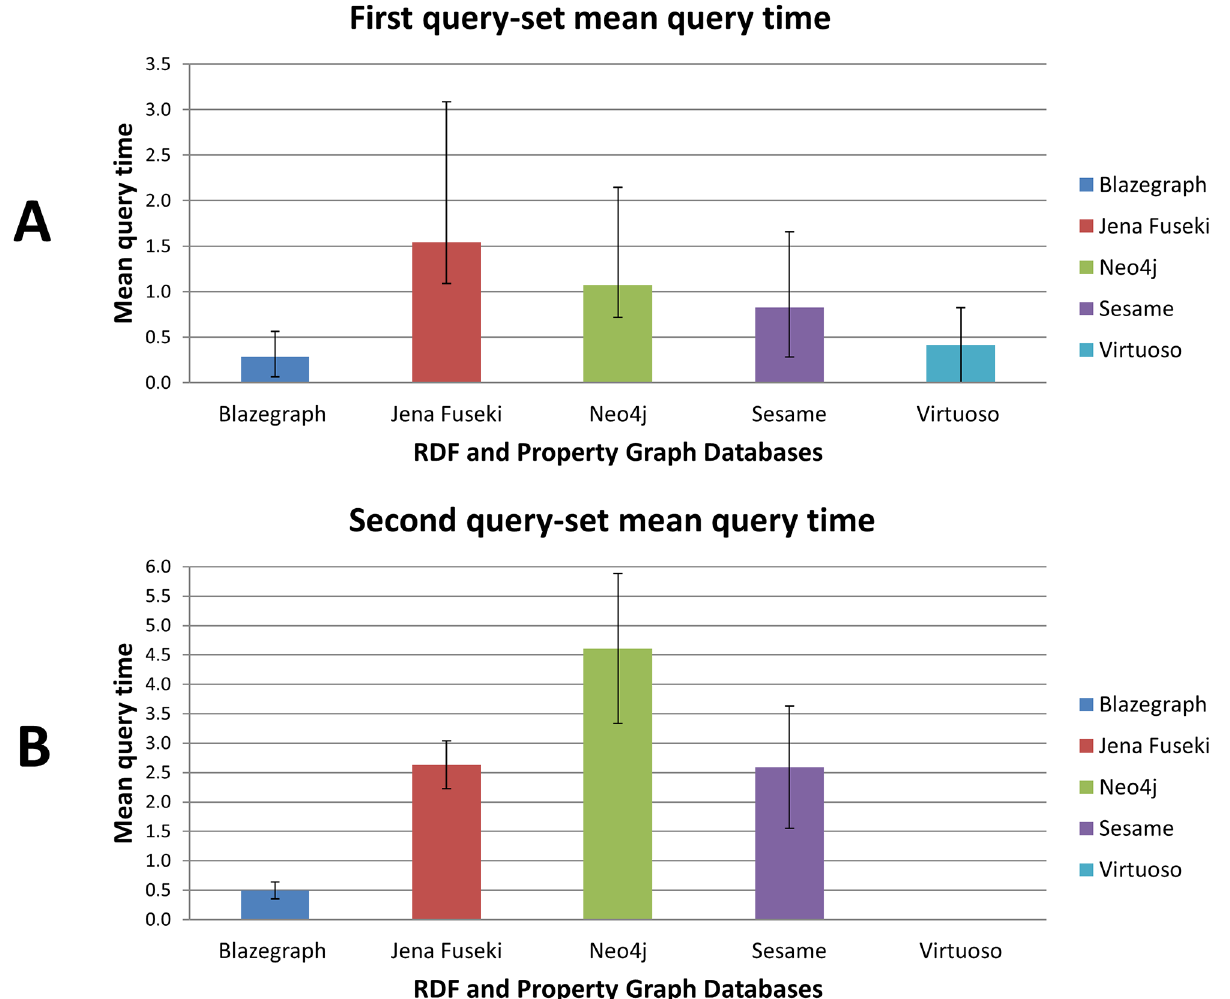
Fig 4. Average query time. The mean value calculated on the response times of each query in both sets is shown in two bar charts. Panel (A) shows the mean query times for the first set and panel (B) contains the values for the second set. The column assign to Virtuoso in the second set of query is empty because we could not record any data due to a problem in running large and very large